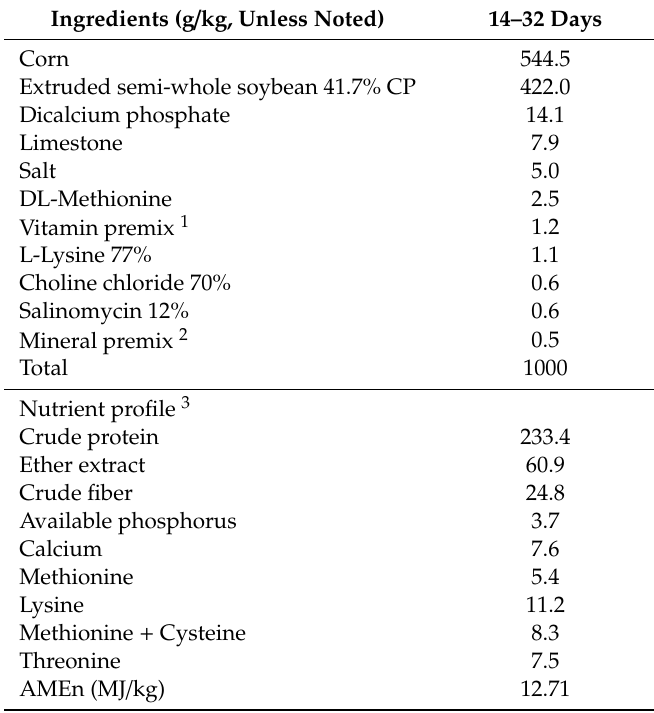
Table 1. Composition of the standard diet of control group, as fed basis. Ingredients (g / kg, Unless